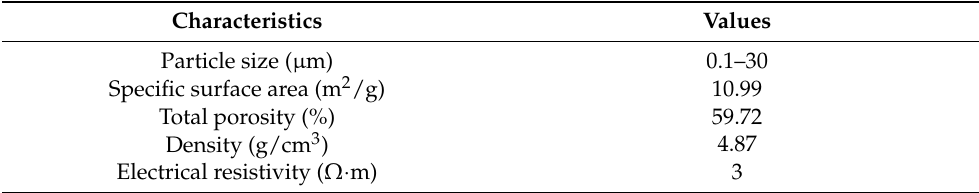
Table 1. Particle size and characteristics of